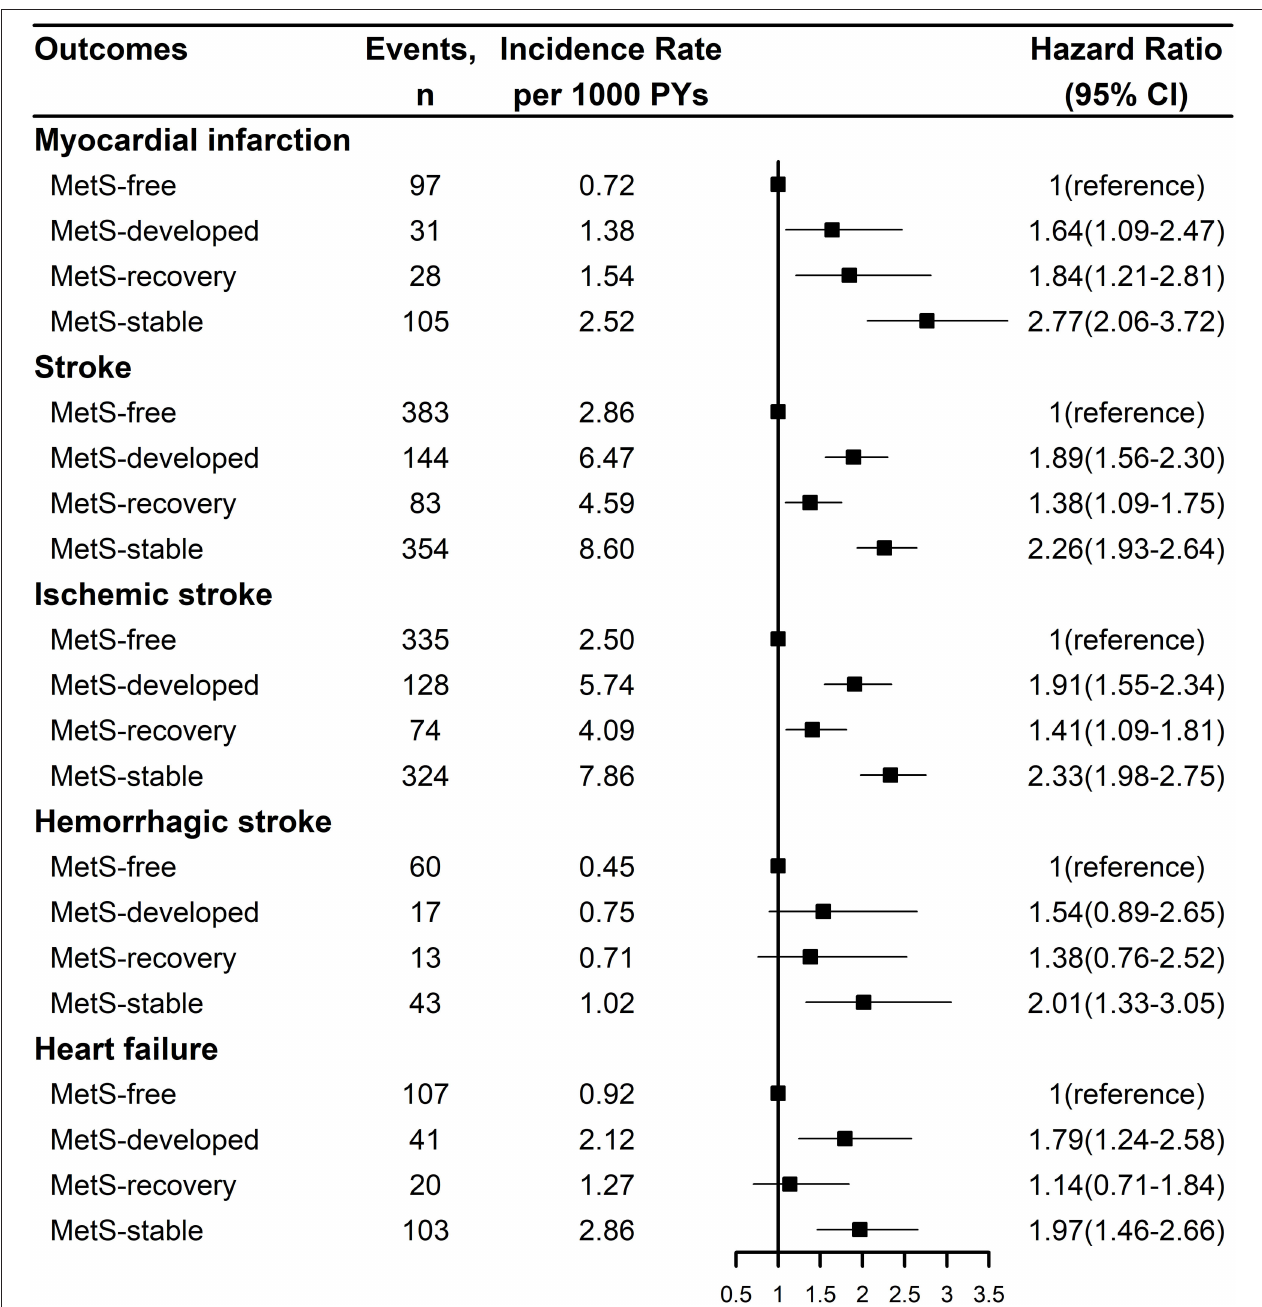
FIGURE 4 | Incidence rates and risks of the subtypes of cardiovascular disease by the dynamic patterns of MetS. Stroke was the composite of ischemic stroke and hemorrhagic stroke. Hazard ration was adjusted for age, sex, marital status, education level, smoking status, drinking status, physical activity level, salt intake, use of anti-hypertensive drug, anti-diabetic drug, lipid-lowering drug, and family history of myocardial infarction, stroke. MetS, metabolic syndrome; PY, person-year; CI, confidence interval.